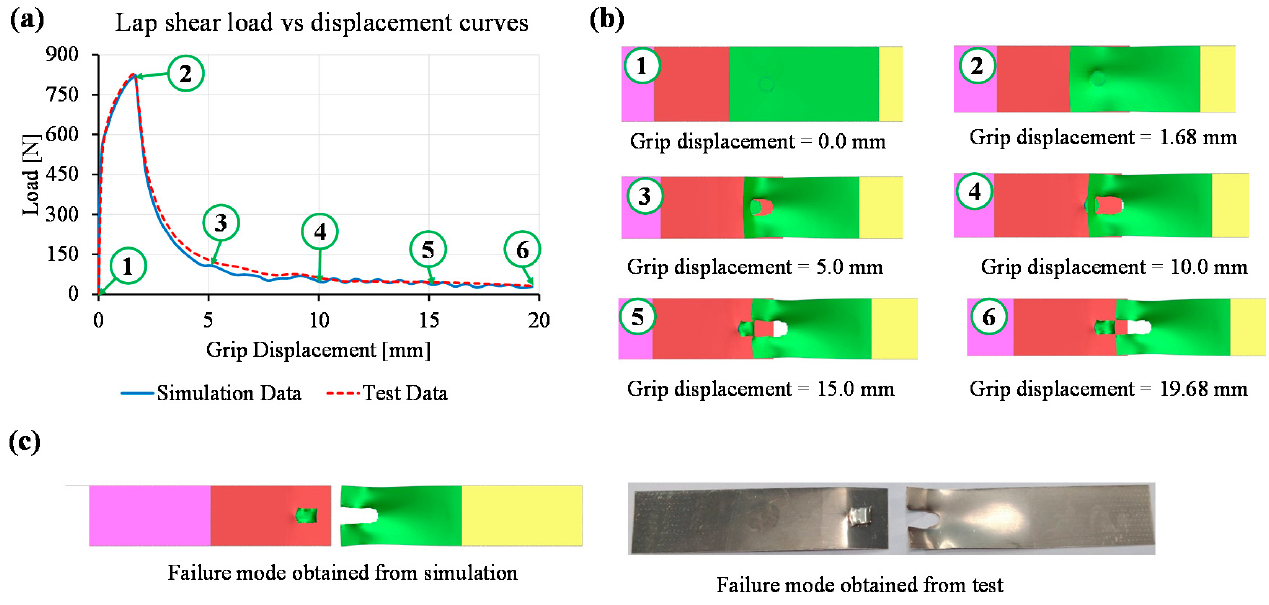
Figure 9. Impact of fracture strain on maximum T-peel load obtained by performing T-peel simula- tions.